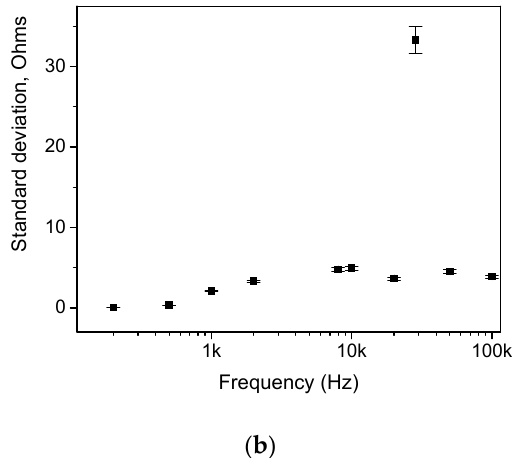
Figure 4. ( a ) Modelled characteristics of the modulus and the phase of the complex resistance taking into account the parallel resonance for an equivalent circuit from Figure 2 with capacitor; ( b ) standard deviation between experimental and modelled curves.